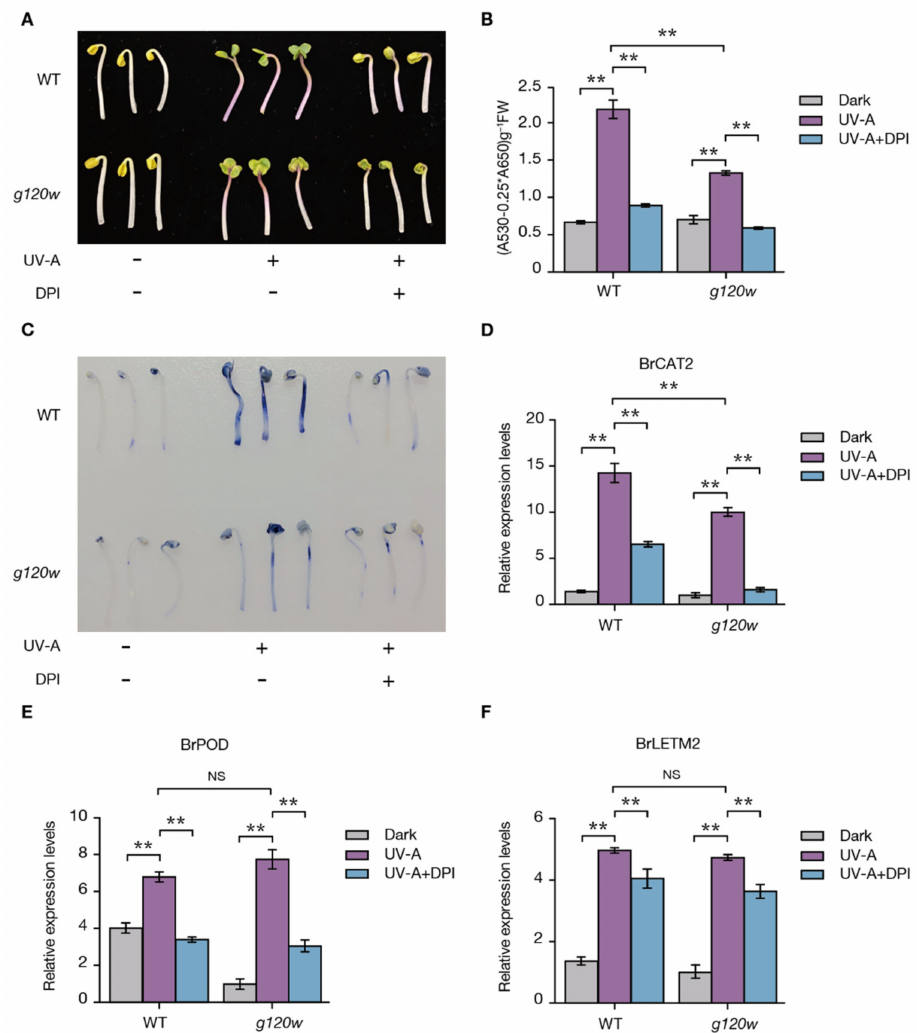
Figure 6. BrLETM2 is a positive regulator of ROS production and anthocyanin accumulation under UV-A irradiation. ( A ) Effects of UV-A and DPI on the morphology of turnip sprouts. ( B ) Anthocyanin levels of hypocotyls in ( A ). ( C ) NBT staining of turnip sprouts in ( A ). ( D – F ) qRT-PCR analysis of BrCAT2 , BrPOD , and BrLETM2 expression levels in hypocotyls in ( A ). Mean ( ± SD) expression levels were normalized by BrACTIN7 , and results for g120w in darkness were set at 1. Asterisks indicate significant difference between different treatments in WT and g120w (** p < 0.01, Student’s t -test, n =